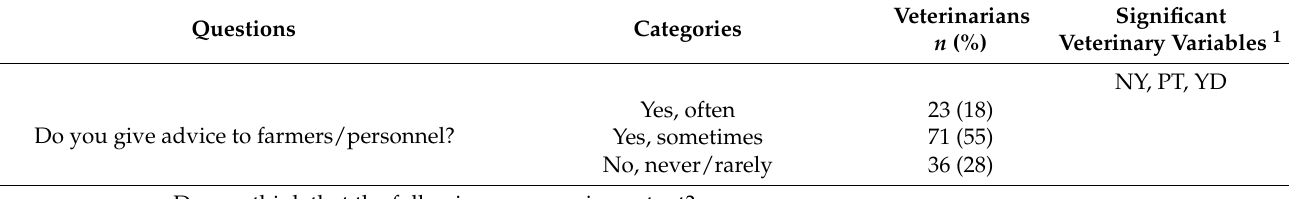
Table 4. Answers to questions about giving advice regarding the dry period of dairy cows to farmers and personnel given by veterinarians ( n = 130) responding to a web-based questionnaire. Associations between veterinary variables and answers were investigated by univariable regression models. If significant ( p ≤ 0.05) the veterinary variables are presented (see Supplementary Table S5 for